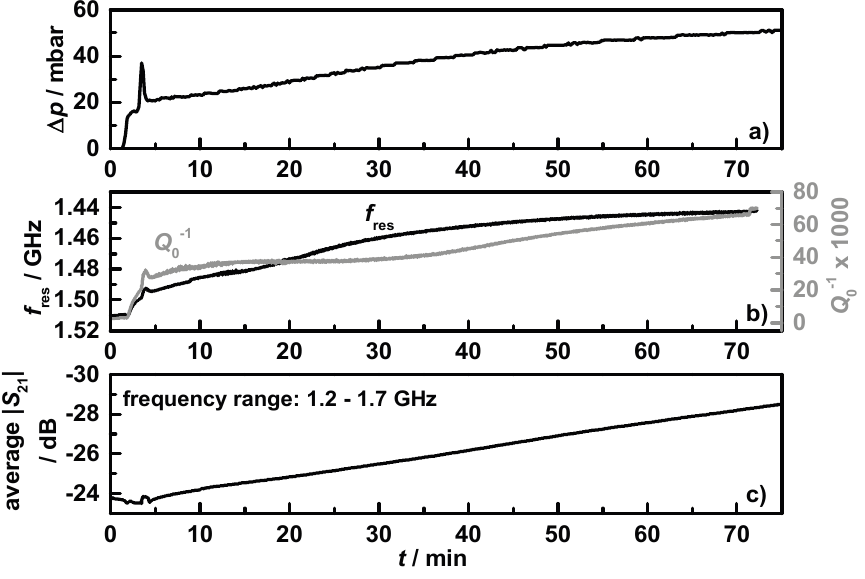
Figure 10. Beginning of the 6 h soot loading experiment on filter C1 with ( a ) the differential pressure; ( b ) the resonance frequency (black) and reciprocal quality factor (grey); and ( c ) the averaged transmission parameter in the frequency range from 1.2 to 1.7 GHz. The whole six-hour lasting soot loading run for filter C1 is shown in Figure 11. The solid grey curve stands for the differential pressure and the averaged transmission parameter is indicated by the black curve.